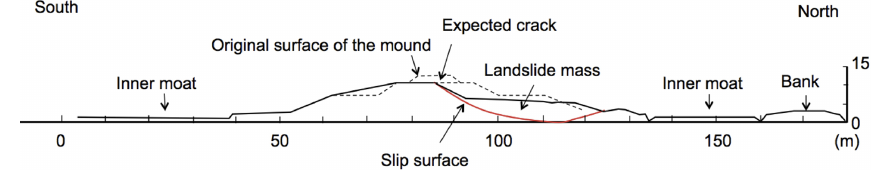
Figure 2. Cross-sectional view of the mound along Line F in Fig. 1. The dashed lines indicate the original surface of the mound, and the red lines indicate the slip surface of the landslide triggered by the 1596 Fushimi earthquake. The authors drew this image based on the work done by Kamai et al.